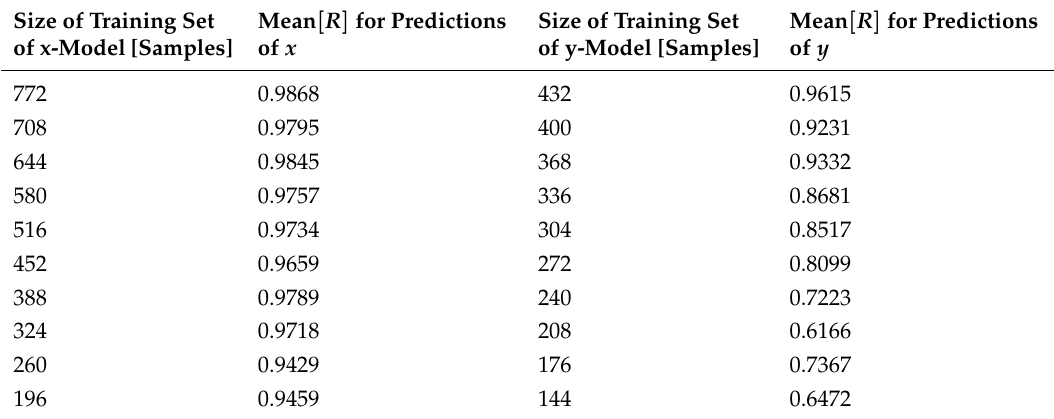
Table 1. Sensitivity of the prediction accuracy (mean [ R ] ) of the ( x , y ) models to the size of the training